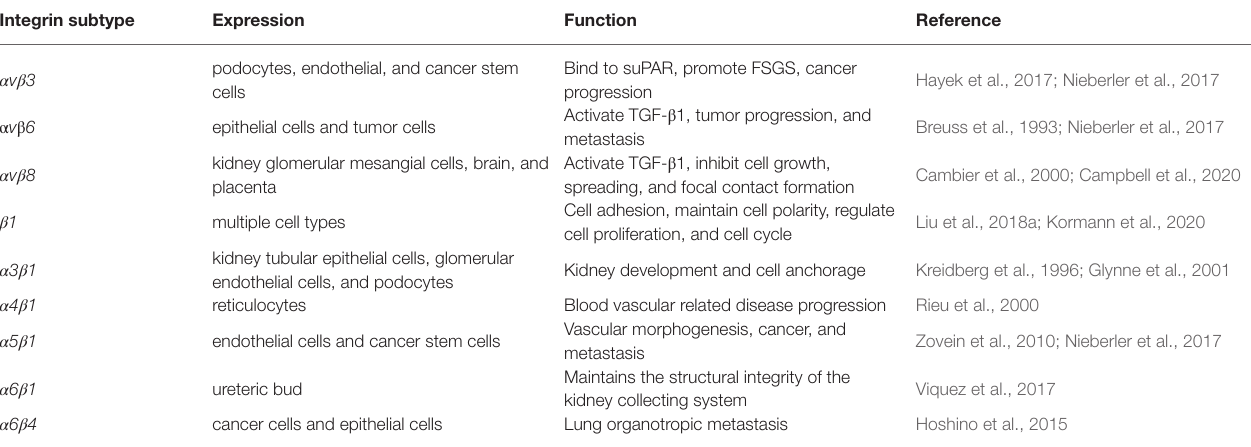
TABLE 1 | Expression and function of major integrin